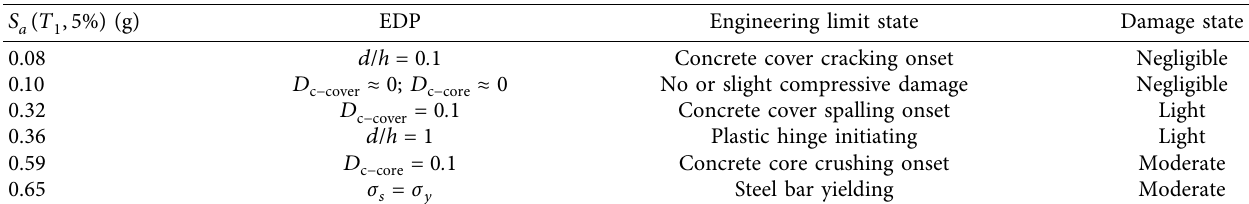
of column B. (c) D of column B. (d) Reinforcement stress. c − cover c − core Table 5: Engineering limit state and damage state prediction.